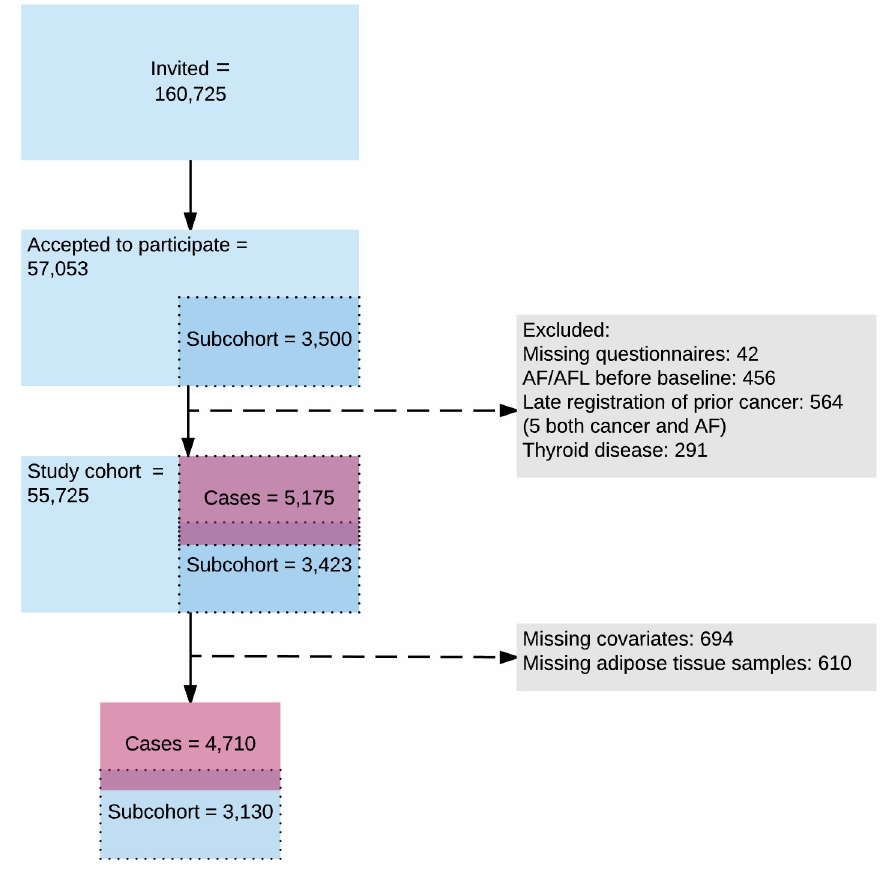
Fig 1. Flowchart of the participants in the Diet, Cancer and Health cohort